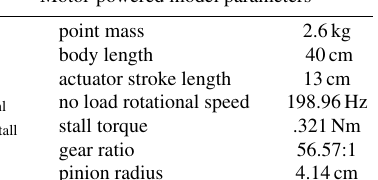
Table 1 Motor-powered model parameters